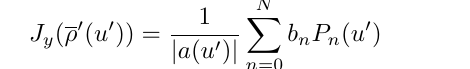
Figure 3: Comparaison of 2D mesh (i) 20 Straight line (ii) 6 NURBS curve